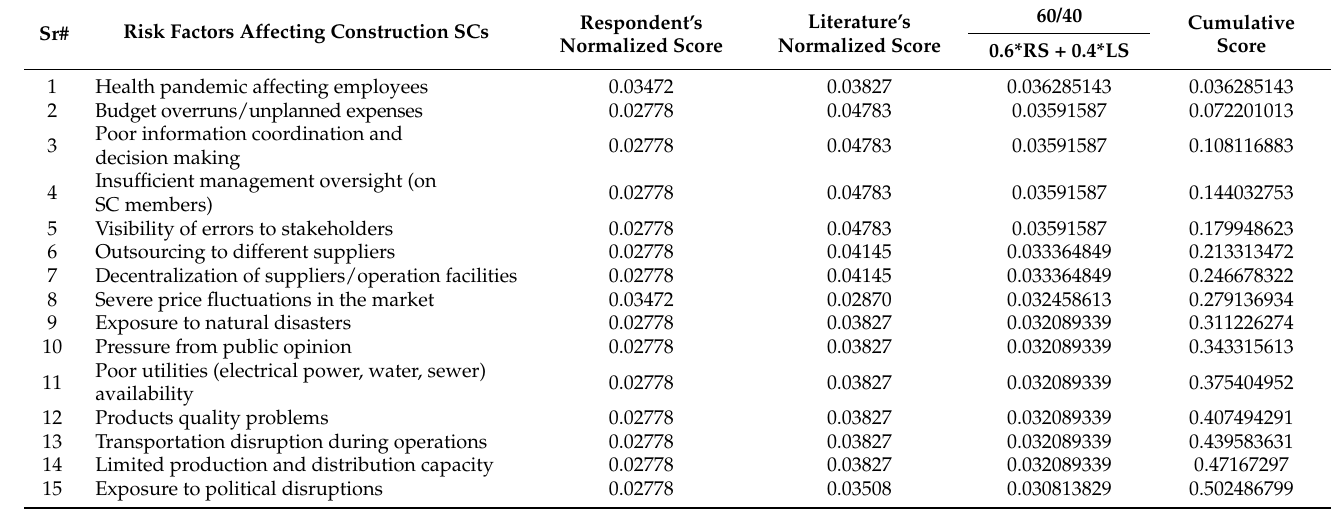
Table 2. Shortlisted risk factors affecting construction SCs with normalized and cumulative